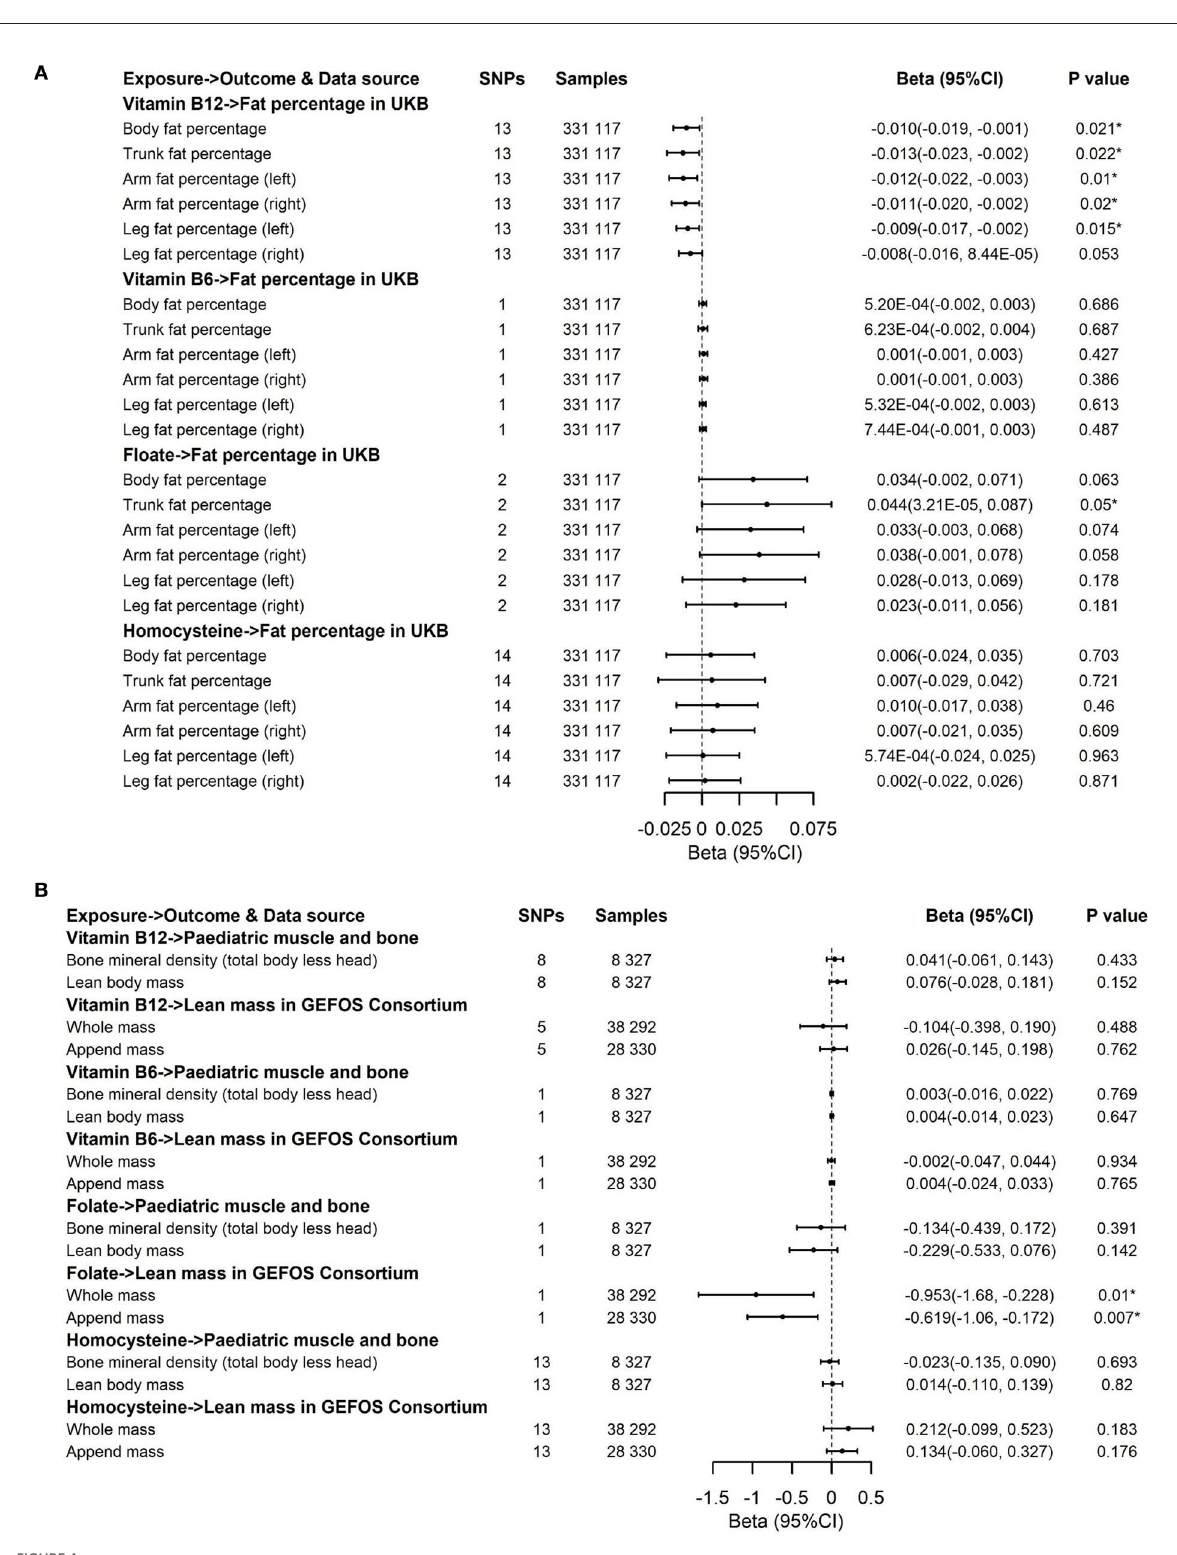
FIGURE4 Effects of genetically predicted circulating homocysteine, vitamin B6, folate, and vitamin B12 on fat percentage (A) and lean mass (B) via IVW method. CI, confidence interval; GEFOS, GEnetic Factors for OSteoporosis Consortium. The summary statistics data of UKB can be downloaded from Nealelab (http://www.nealelab.is/uk-biobank). The summary statistics data in FinnGen Consortium can be downloaded from Google cloud storage free of charge (https://www.finngen.fi/en/access_results). * P value reached the significant level; SNP, single nucleotide